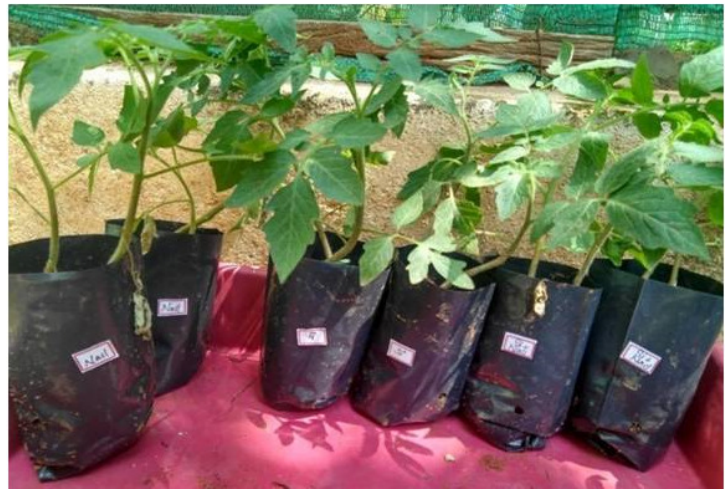
Figure 1. Plants under greenhouse